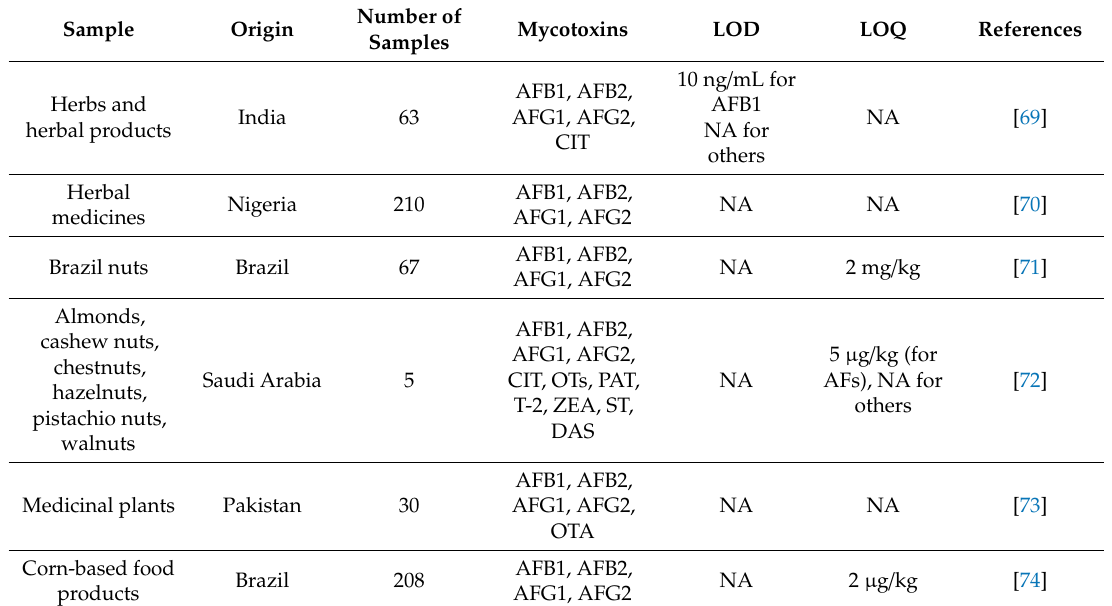
Table 2. Examples of thin-layer chromatography (TLC) techniques for mycotoxin